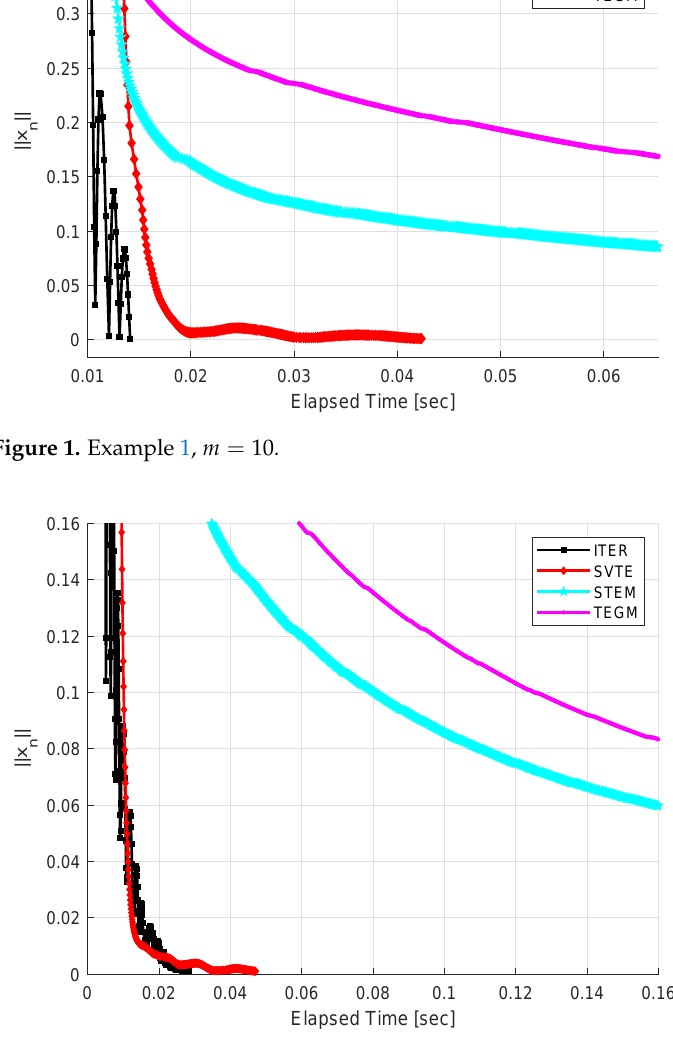
Figure 2. Example 1, m =